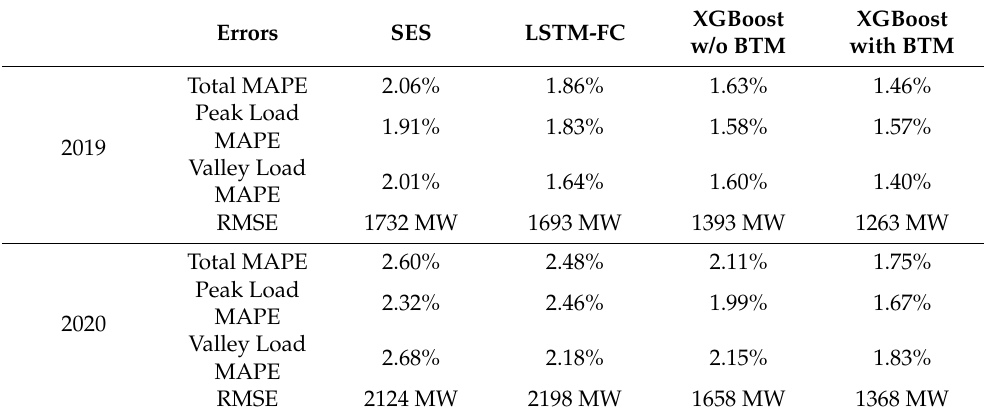
Table 5. Performance comparison of forecasting methods for 2019 and